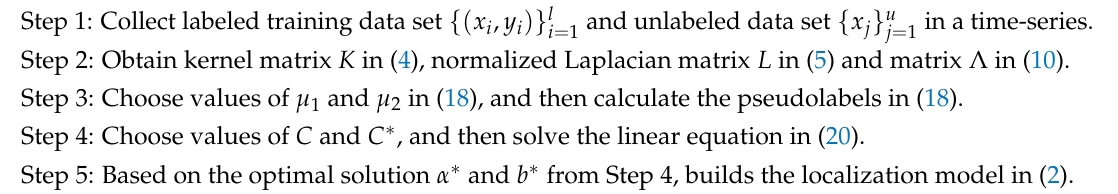
Algorithm 1 Proposed semi-supervised learning for